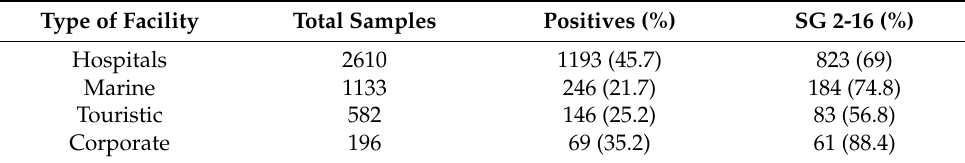
Table 1. Legionella screening in water systems of central eastern Sicily